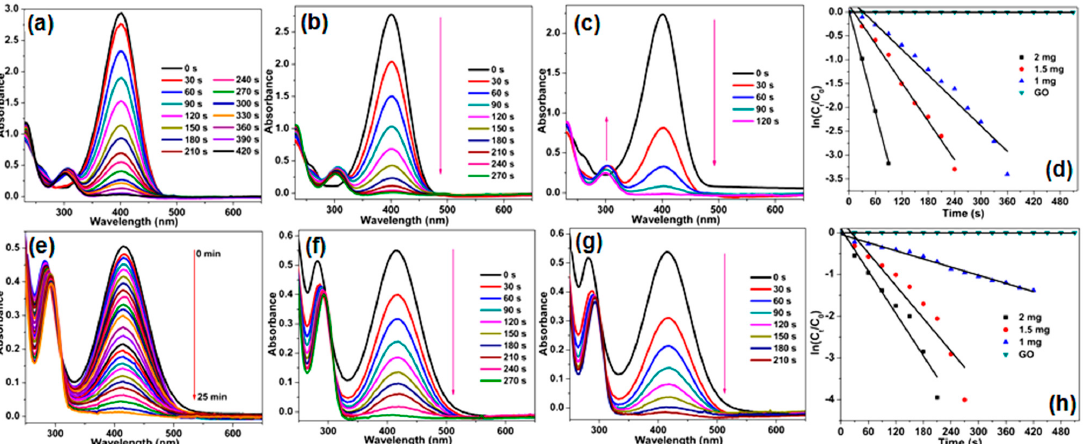
Figure 10. UV–vis spectra of the reduction of ( a – c ) 4-NP and ( e – g ) 2-NP in aqueous solution recorded every 30 s using different amount of Ni/GO-1 (1.0, 1.5 and 2 mg). Plots of ln[C t /C 0 ] versus reaction time for the reduction of ( d ) 4-NP and ( h ) 2-NP with NaBH 4 over Ni/GO-1.